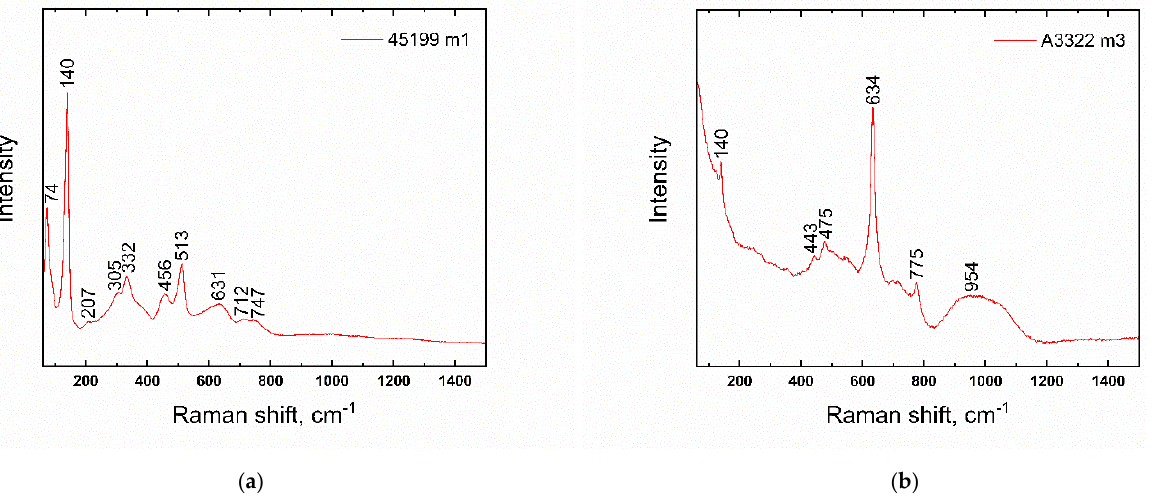
Figure 10. Raman-spectra of opacifying agents. ( a ) Pb 2 Sb 2 O 7 bead No. 21; ( b ) SnO 2 ; bead No. 32. Red-Colored